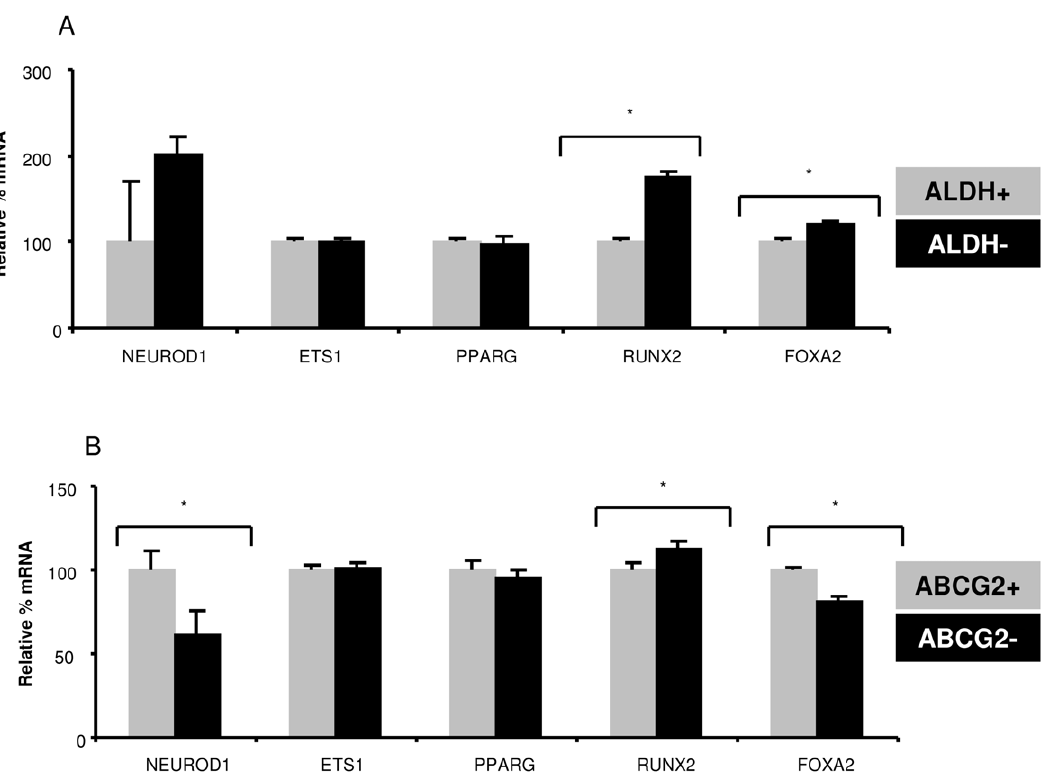
Figure 6. Differential profile of stem cell biology-implicated transcription factors in ALDH + / 2 and ABCG2 + / 2 cells sorted from CHA59 spheres. (A) ALDH + / 2 subpopulations were sorted from CHA59 spheres using ALDEFLUOR staining and FACS. Subsequently, expression of various genes was measured in the sorted population by real-time RT-PCR analysis. *p , 0.05. (B) ABCG2 + / 2 subpopulations were sorted from CHA59 spheres using an anti-ABCG2 antibody and FACS. Thereafter, expression of various genes was measured in the sorted population by real-time RT-PCR analysis. *p , 0.05.